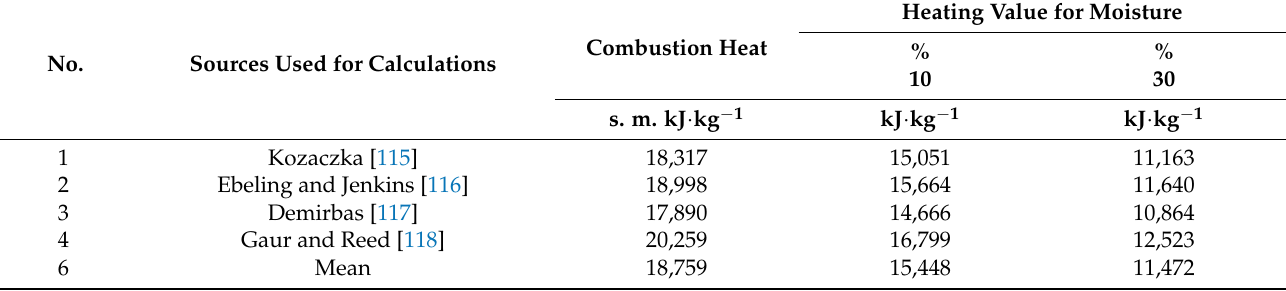
Table 14. Caloric value of Miscanthus, calculated on the basis of the elementary composition, according to various sources, for selected humidities